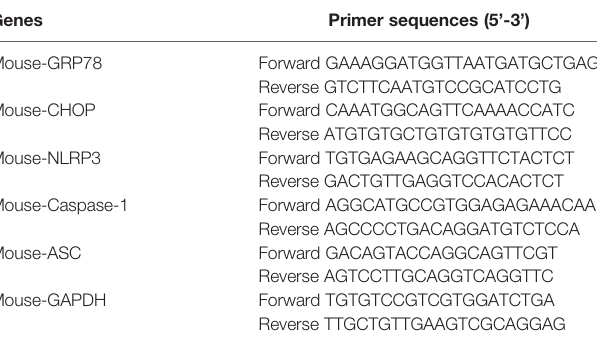
TABLE 1 | Sequences of the primers used to quantitate gene